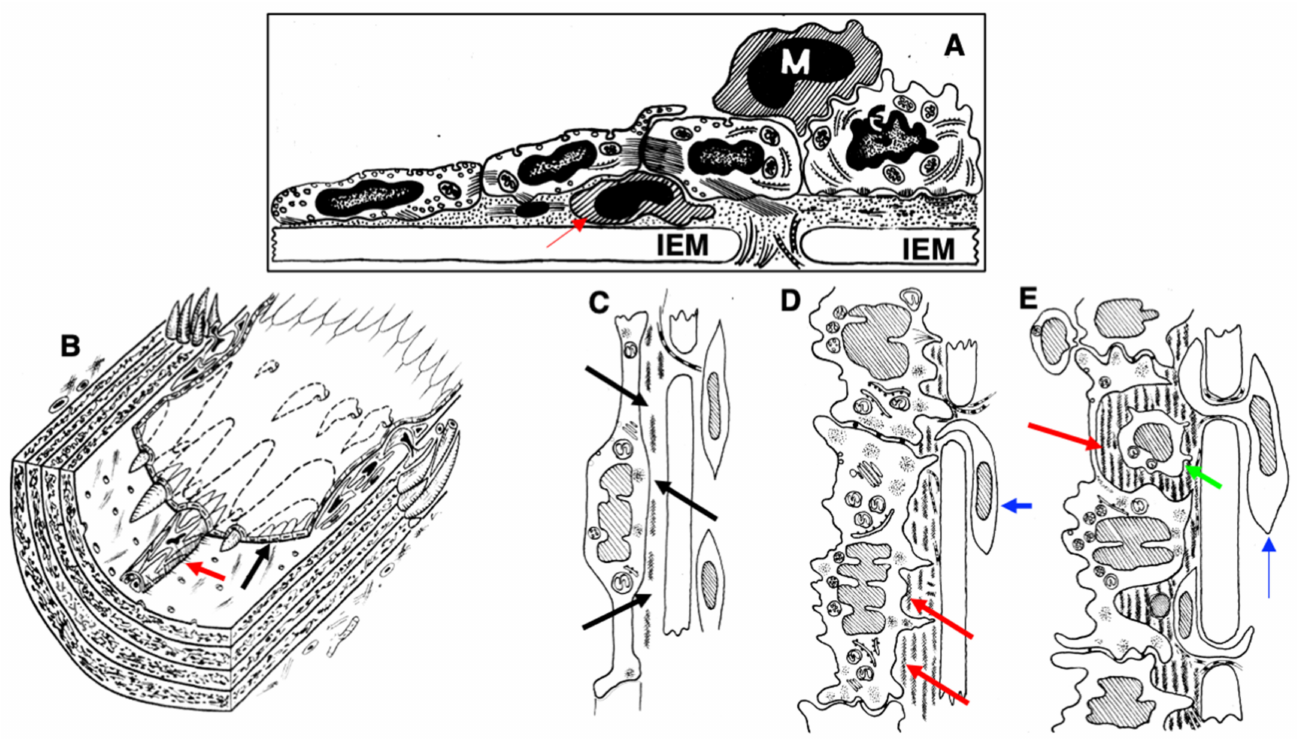
Figure 12. Schemes illustrating the process of EC regeneration. ( A ) Scheme demonstrating the consequence of event during endothelial regeneration after cryoinjuries. Red arrow shows leucocyte in the subendothelial space. M, monocyte. ( B ) Scheme of regeneration of SMCs in aorta after extensive cryoinjury. SMCs form spindle-like extrusion (red arrow) moving within the subendothelial layer (BM is not shown). Black arrow indicates endothelial layer. No SMCs were observed in the media. ( C ) Scheme of the normal intima in the rat aorta. BM has pores (black arrows). ( D ) Thick BM and subendothelial layer (arrow) after a single re-endothelialization. SMCs indicated with blue arrow could enter the subendothelial space only at the edges of the cryoinjury. Enlarged solid parts of BM are shown with red arrows. ( E ) Scheme of the aortic intima in hypertensive and old rats, and after multiple re-endothelialization. Pore in BM became narrow. Solid parts of BM is indicated with the red arrow. Leucocytes (green arrow) are accumulated in the subendothelial layer (from Mironov et al., [4]).